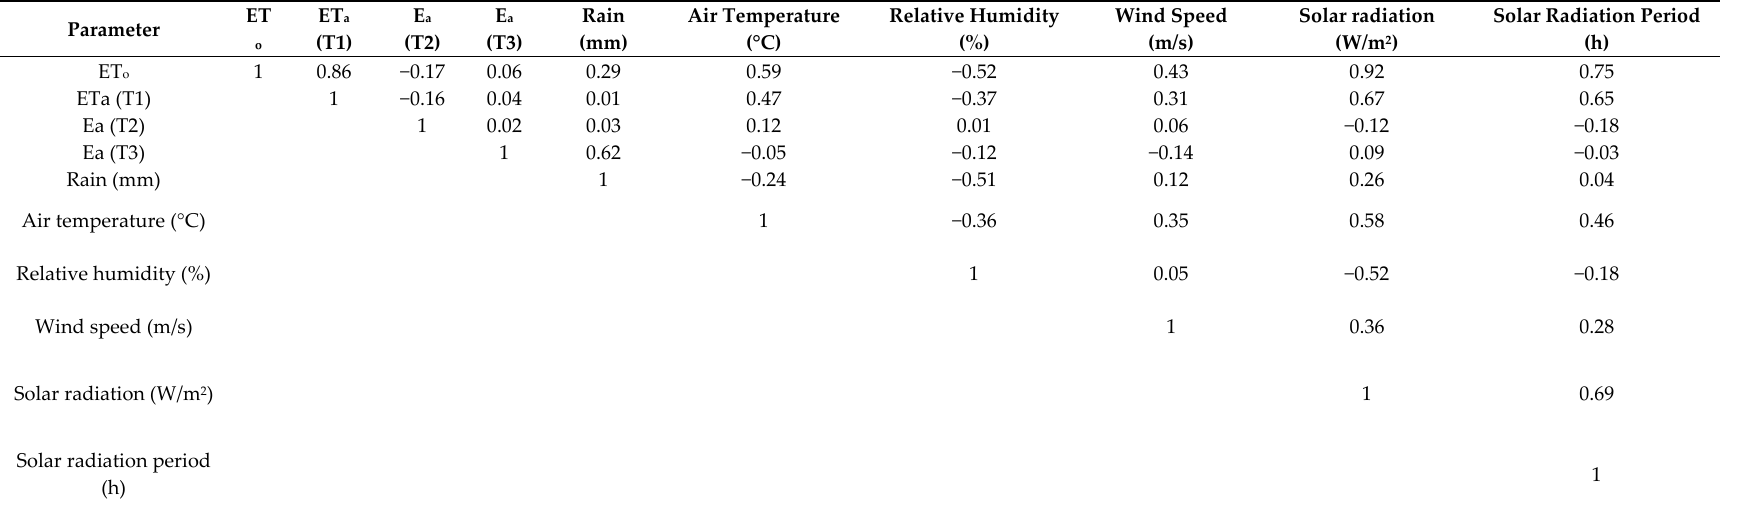
Note: Marked values indicate good correlation (R > 0.5)